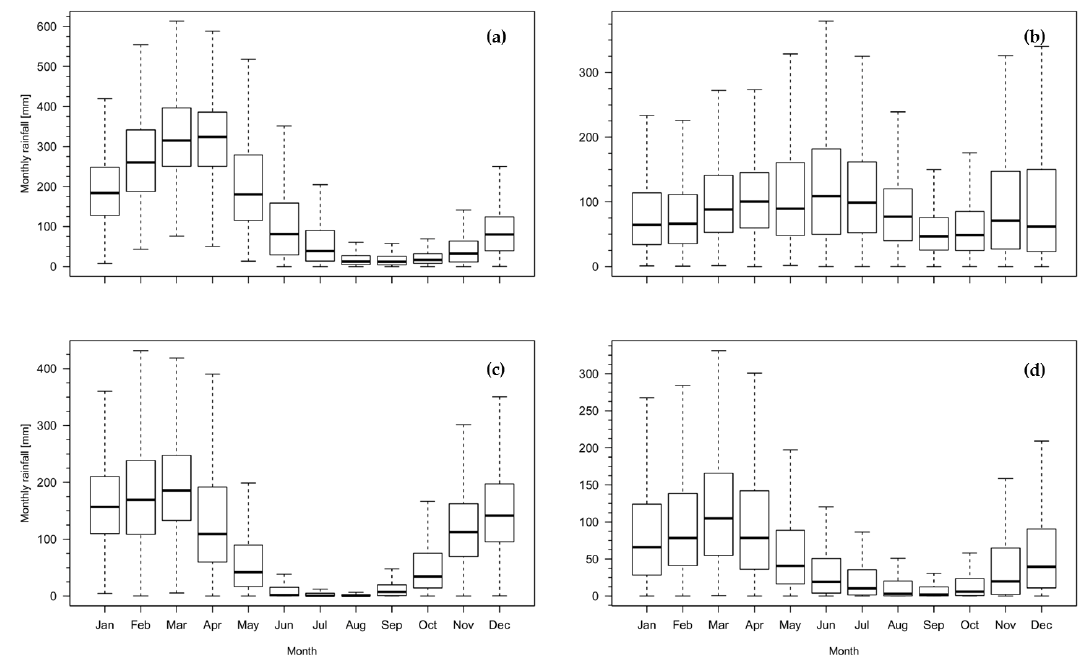
Figure 5. Boxplots for the mean monthly rainfall estimated by GBGR over the biomes: ( a ) AMZ; ( b ) MAT; ( c ) CER; and ( d ) CAAT during the period 1998–2015. The center line of each boxplot depicts the median value (50th percentile), and the box encompasses the 25th and 75th percentiles of the sample data. The whiskers extend from q1 − 1.5 × (q3 − q1) to q3 + 1.5 × (q3 − q1), where q1 and q3 are the 25th and 75th percentiles of the sample data, respectively.